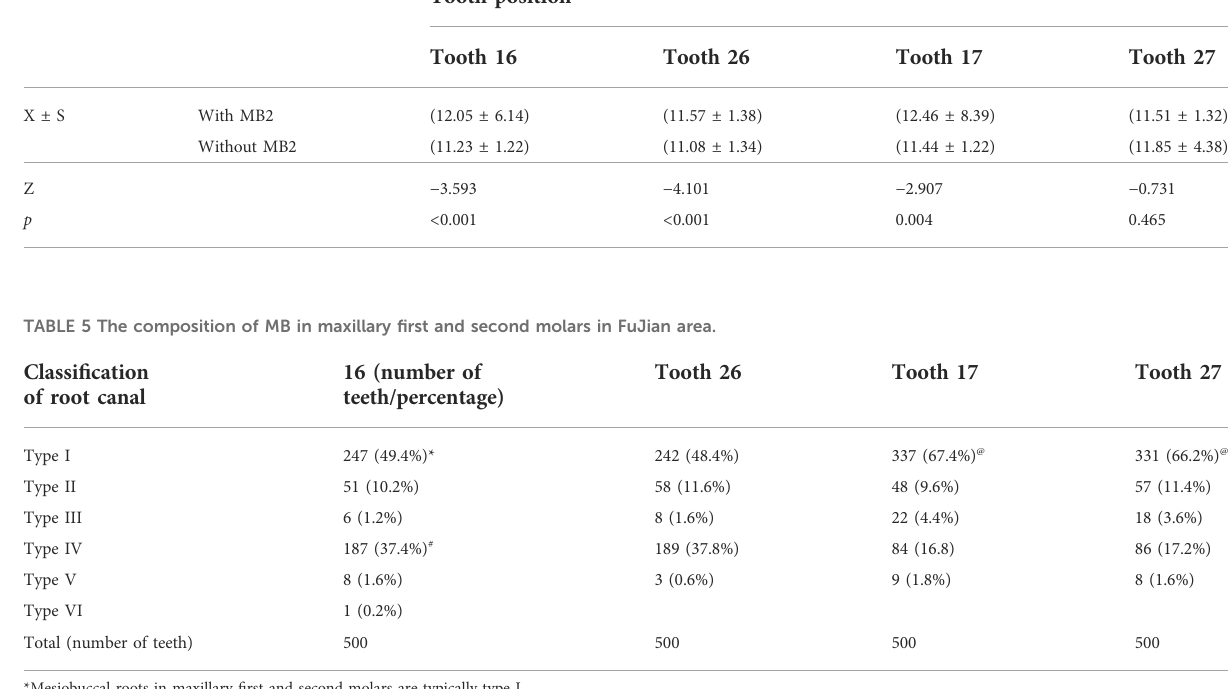
TABLE 4 Comparison of the distance of MB root canal between groups with and without MB2.